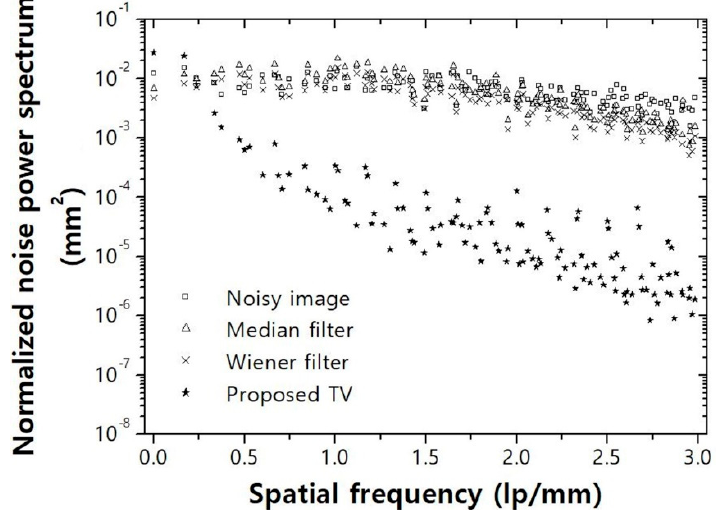
Figure 4. NNPS results (over ROI C shown in Figure 2) obtained for the noisy image, median filter, Wiener filter, and proposed TV noise reduction algorithm applied to the confocal laser scanning micrograph of the tooth specimen.